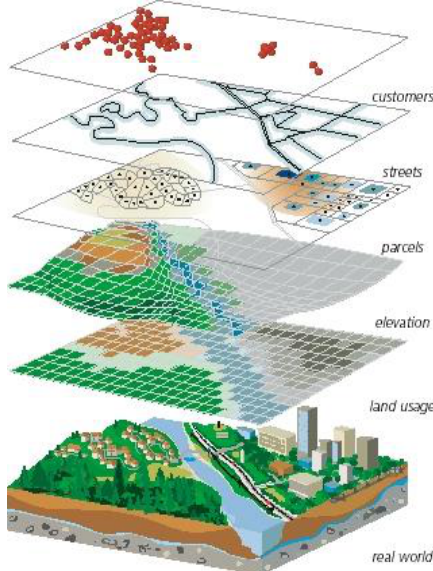
Figure 2: GIS spatial modelling for better management especially for authorized body.